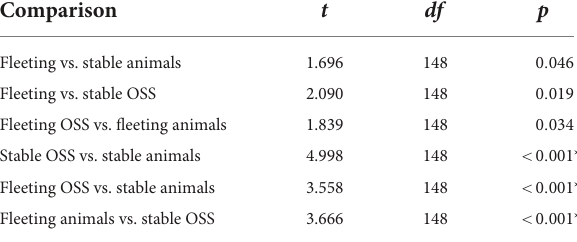
TABLE 3 Stability and animacy interaction